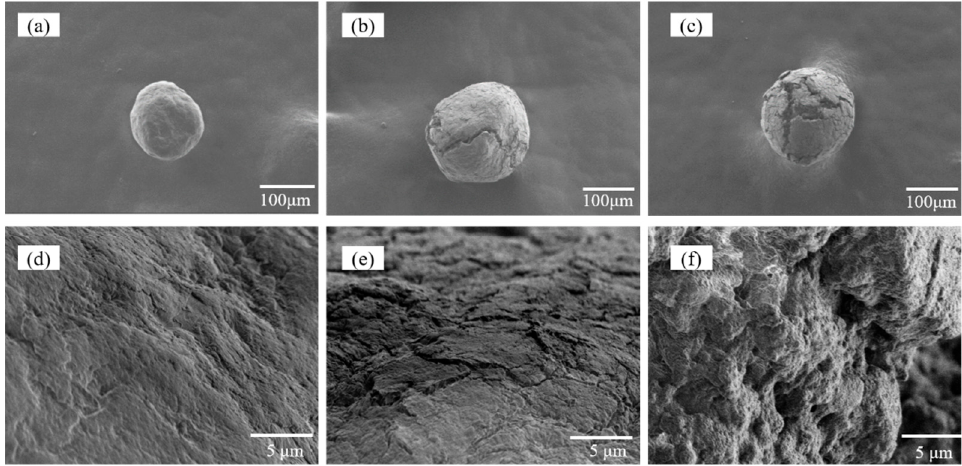
Figure 5. SEM images of ( a ) ( d ) MCM, ( b ) ( e ) MCM- g -PGMA, ( c ) ( f ) MCM- g -AB15C5.